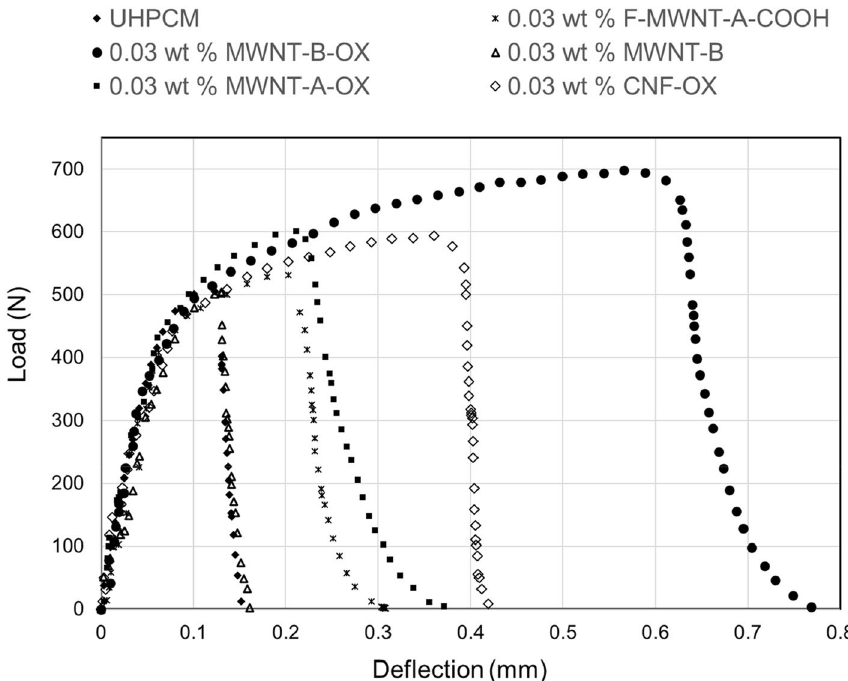
Fig. 5 Typical flexural load– deflection behavior of UHPCM (plain matrix) and 0.03 wt.% of CBNs: MWNT-A-OX and MWNT- B-OX are acid oxidized MWNTs; F-MWNT-A-COOH is MWNT-A fluorination followed by ethyl carboxylation; CNF-OX is acid oxidized CNF; and MWNT-B and MWNT-A are non-function- alized